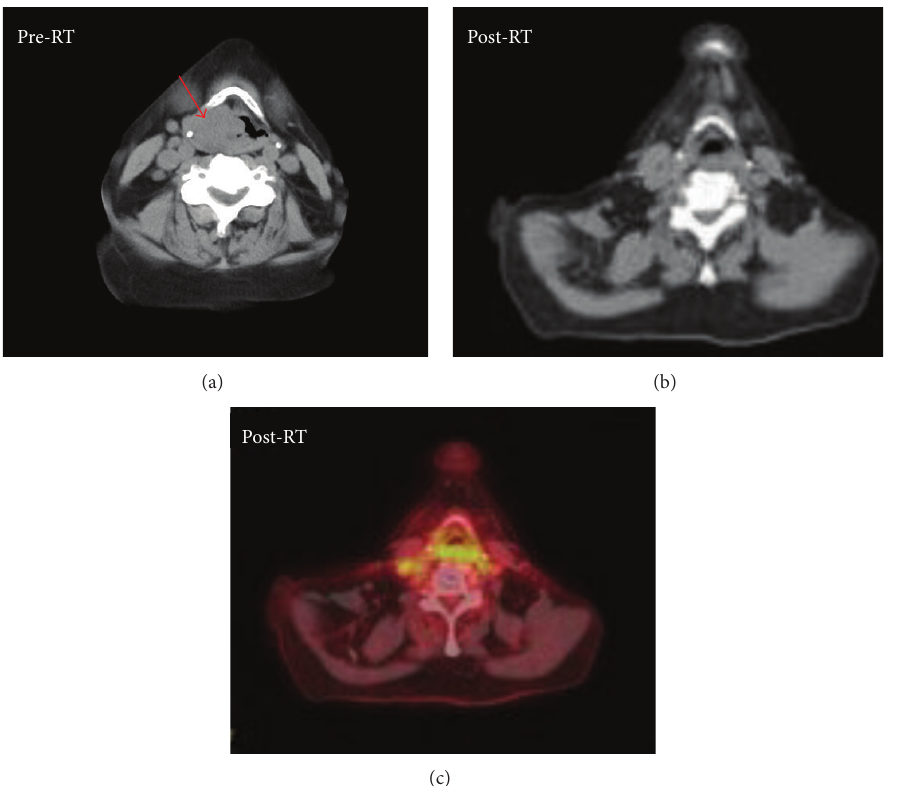
Figure 4: Complete response following radiation therapy. The mass (red arrow) present on CT-based imaging performed at diagnosis (a) has resolved 3 months following radiation (b) and there is no corresponding PET avidity